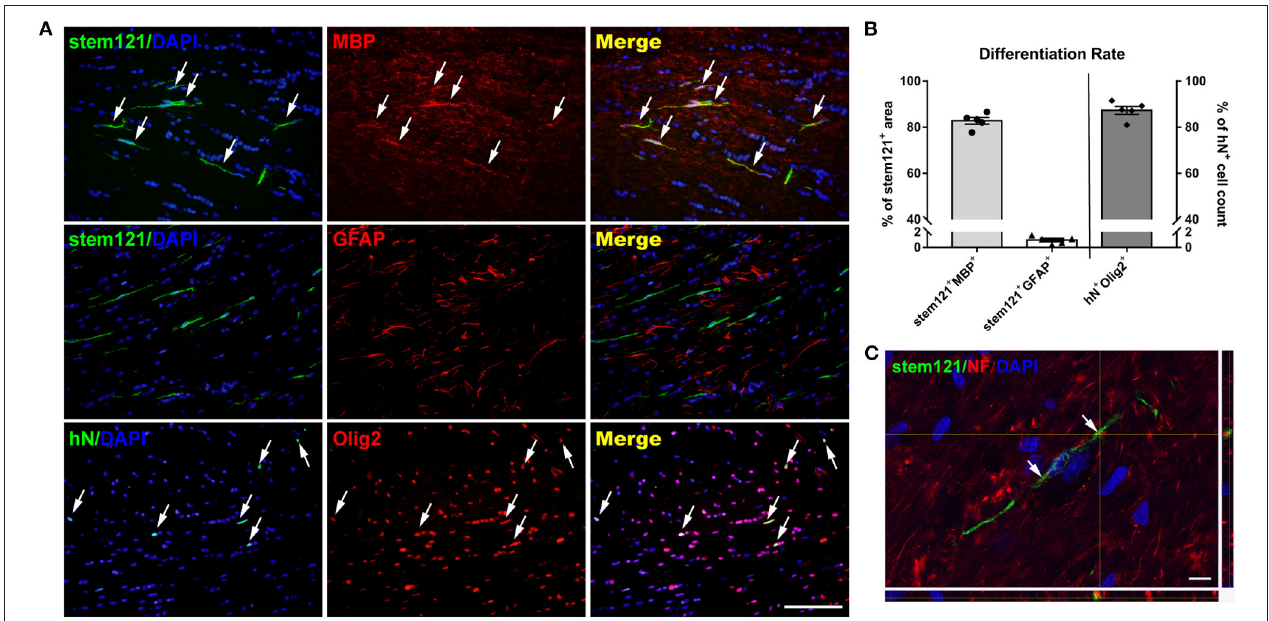
FIGURE 2 | Differentiation of transplanted hOPCs. (A) Representative images of hOPCs differentiation at 13 weeks post-transplantation. (B) More than 80% of transplanted cells co-expressed Olig2 and MBP, and little GFAP co-staining was observed in stem121 + cells ( n = 5 per group; three sections per rat, with three sites randomly sampled per section). (C) Confocal images showed the ensheathment of axons by stem121 + OLs. Scale bar represents 50 µ m in (A) and 10 µ m in (C) . Data are presented as mean ± SEM.